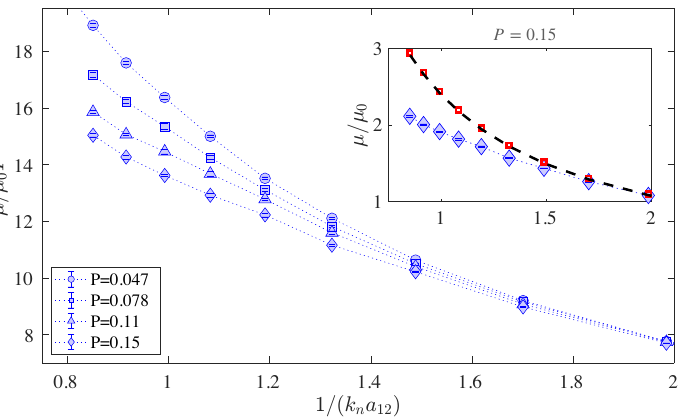
Figure 1. Total polaron energy µ (excited state) as a function of the coupling strength for different polarization P = M / N in the weak and intermediate coupling. The gas parameter is taken to = 10 − 5 . Inset: comparison between perturbation theory and the QMC result for highest be na 3 11 polarization P = 0.15. The red squares represents the theoretical results using perturbation theory in [37] (Subfigure adapted from [49]), whereas the black dashed line depicts the calculation in this work (see Equation (9)), here a 11 = a 22 . Error bars are smaller than the size